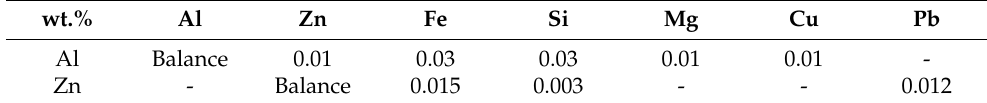
Table 1. Composition of the metals used to prepare the Zn–Al alloys.